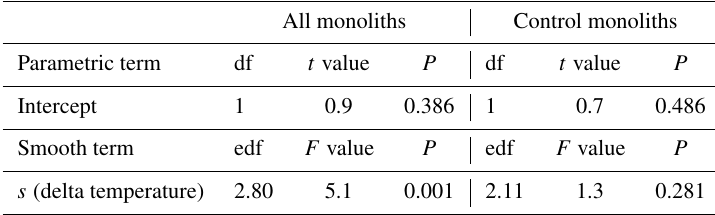
Table B4. Summary of analyses for the effects of temperature change (delta temperature) induced by the climate change treatments on soil carbon stock change (Delta C soil) of subalpine grassland between 2012 and 2017. F and t values and approximate P values refer to a generalized additive model that used a smooth term to delta temperature.